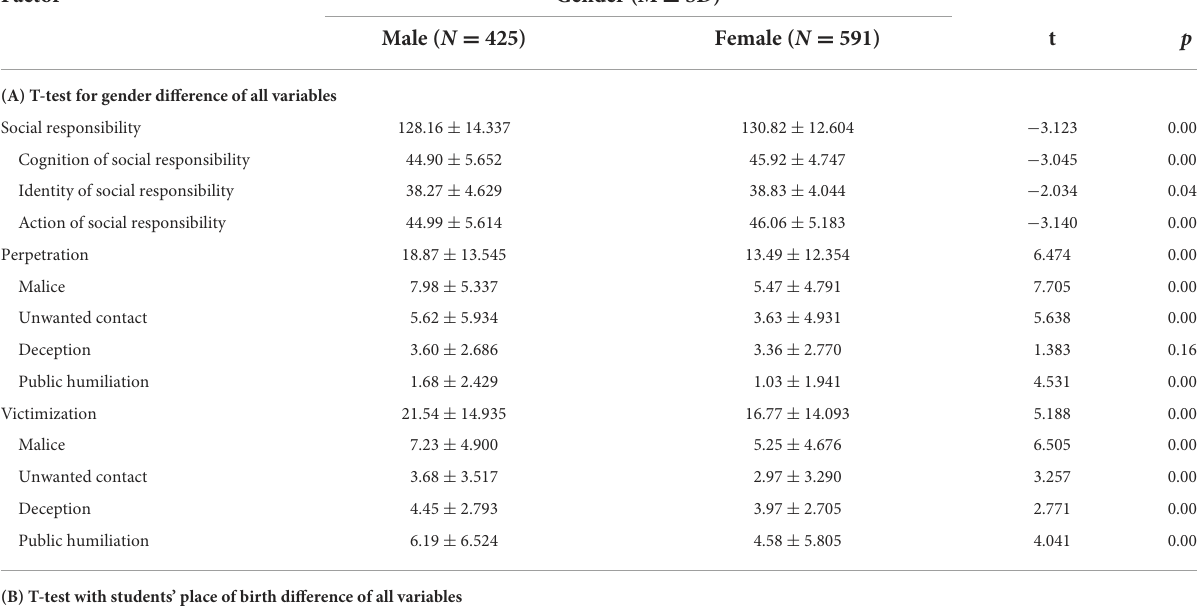
TABLE 1 Difference analysis among